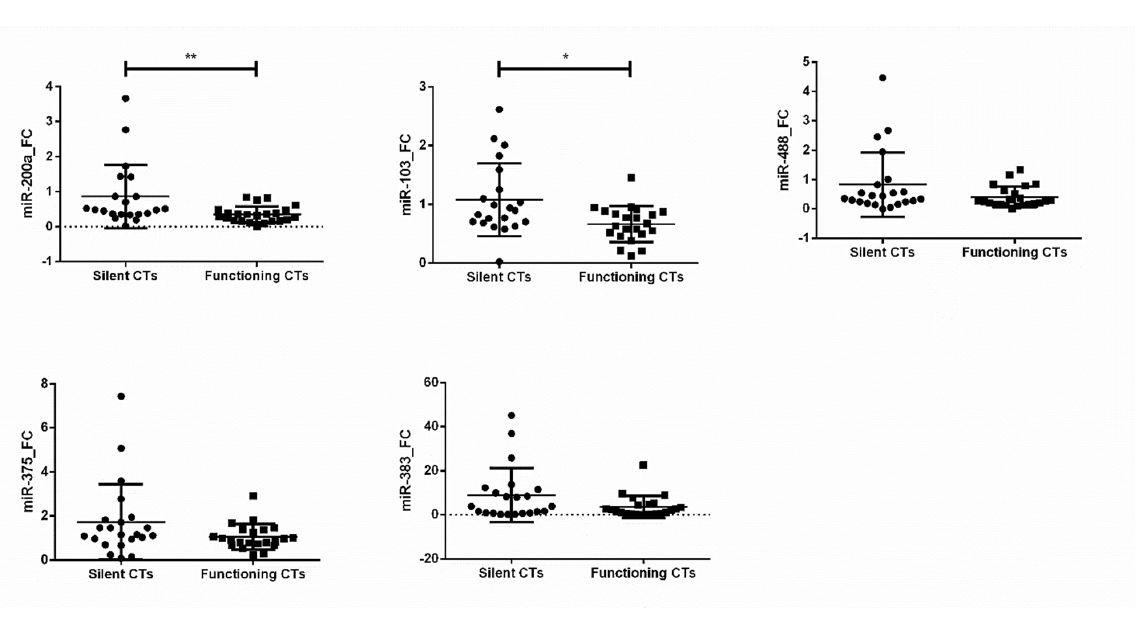
Figure 1. Gene expression differences (fold change) of miR-200a, miR-103, miR-488, miR-375 and miR-383 between silent CTs (corticotroph tumors) and functioning CTs. * p < 0.05; ** p < 0.01. Eliminating the bias of tumor size, significant differences held between macro silent CTs and macro functioning CTs ( p = 0.049 and p = 0.05, respectively). Therefore, we performed a ROC curve